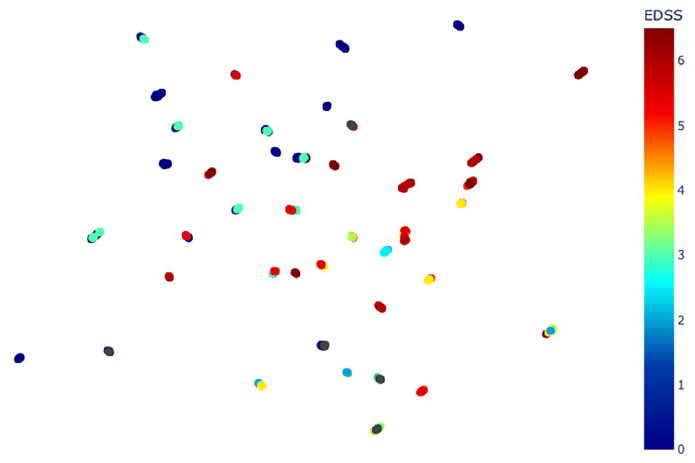
Fig 9. UMAP plot obtained using the difference of walking speed as a distance between signals, colored by